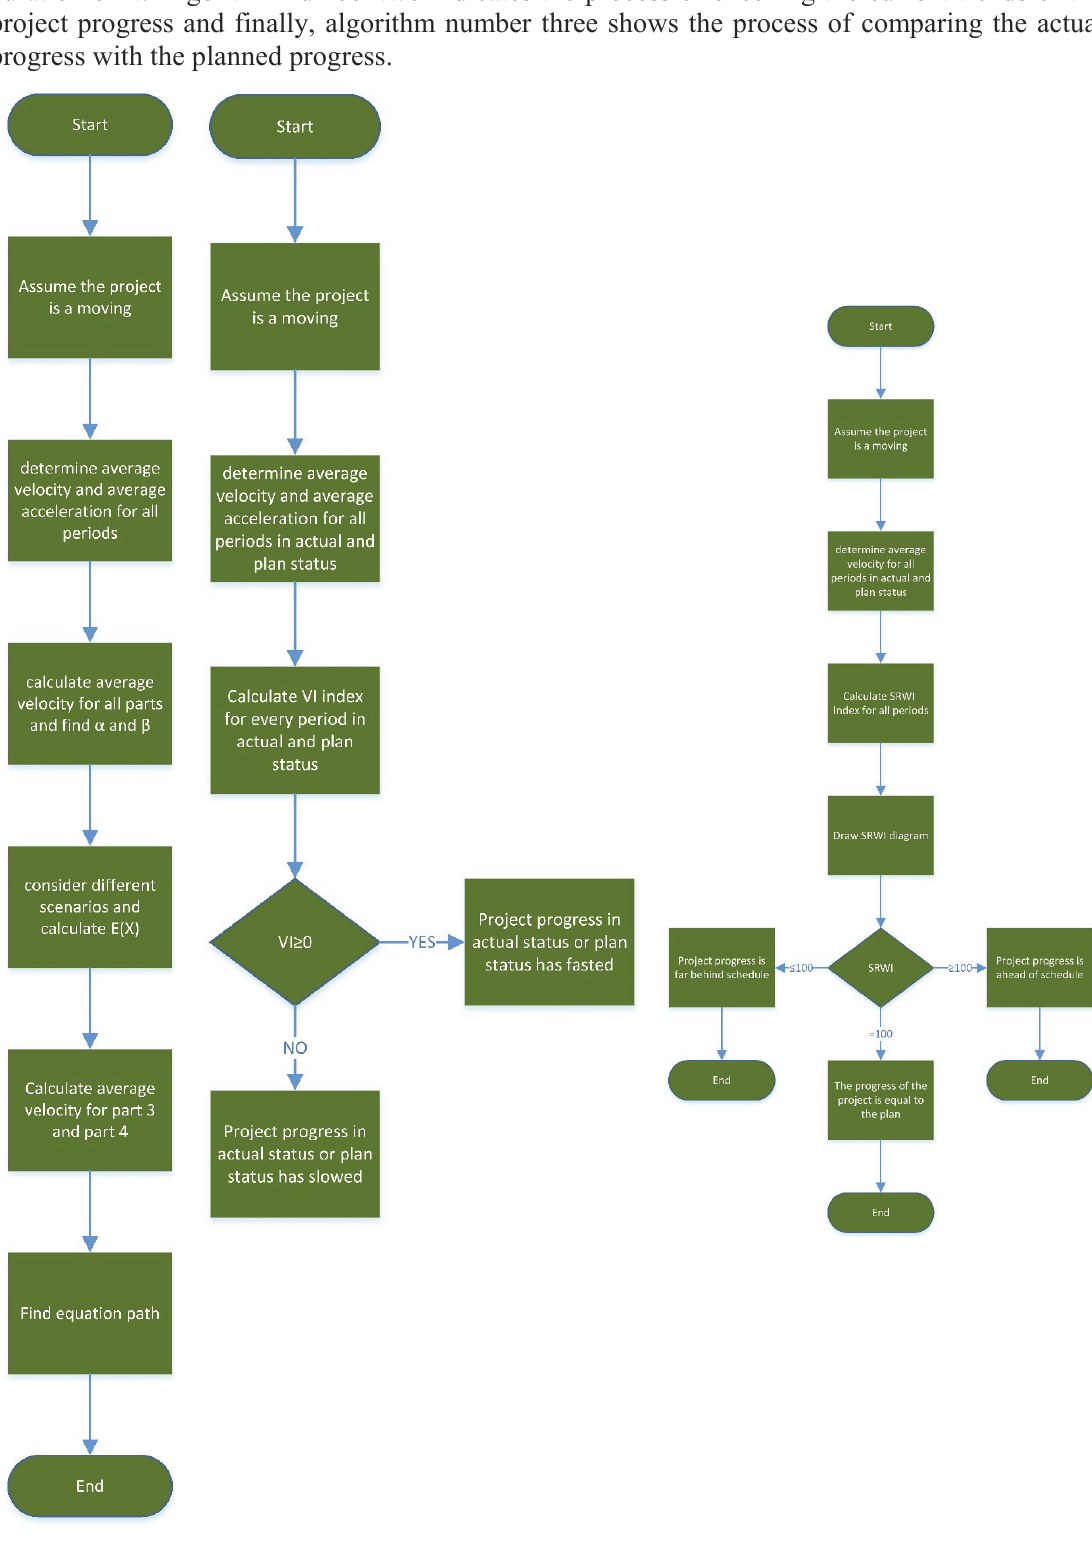
Fig. 1. Algorithm Fig. 2. Algorithm number two Fig. 3. Algorithm number number one